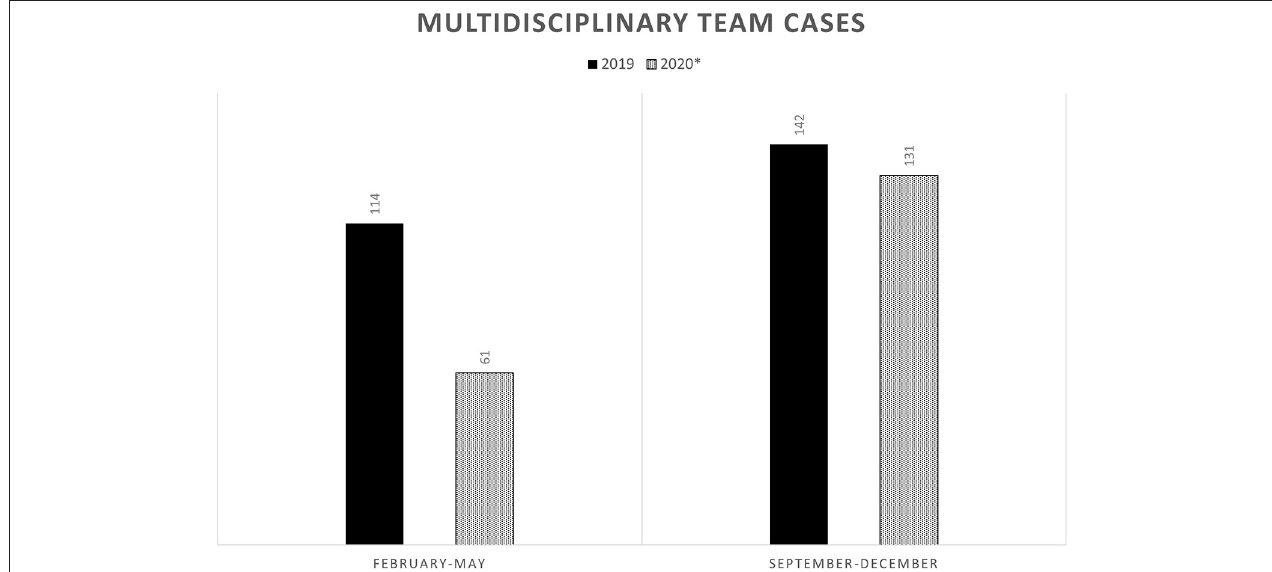
FIGURE 1 | Multidisciplinary team cases of non-small cell lung cancer discussed in the two phases of Covid-19 pandemic and compared with the previous